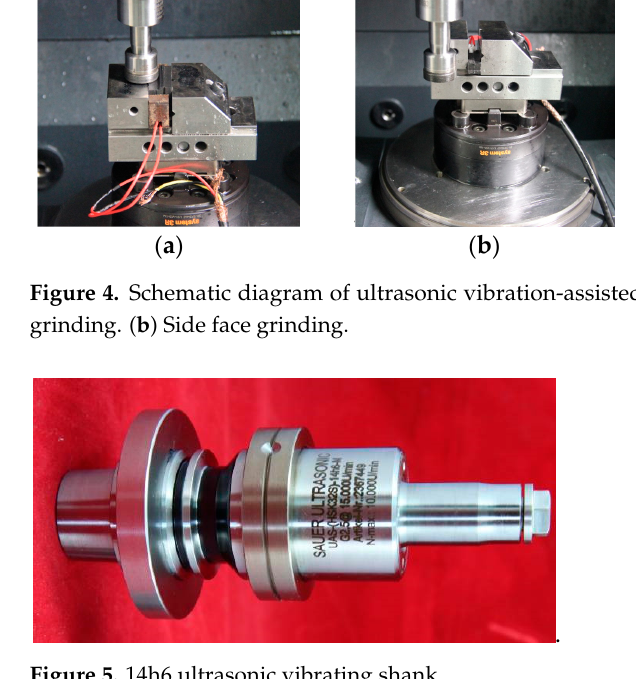
Figure 5. 14h6 ultrasonic vibrating shank.